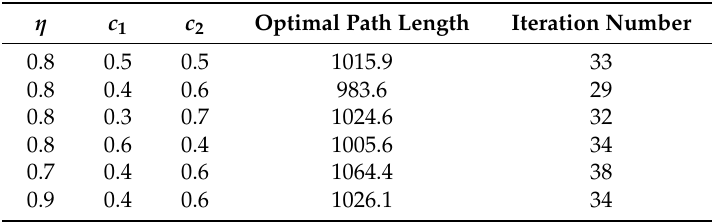
Table 4. Optimal path length under different PSO parameters